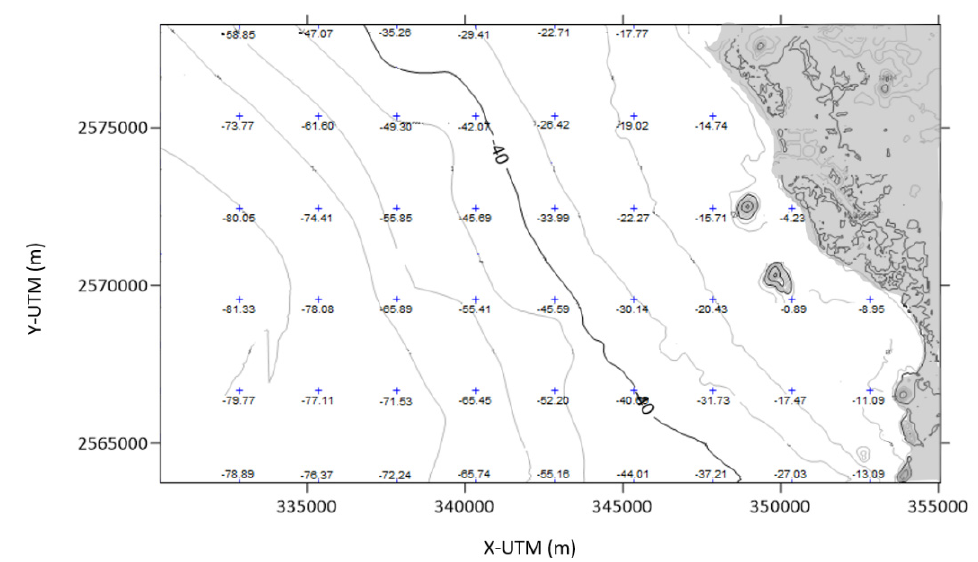
Figure 4. Bathymetry of the study area, soundings in meters.